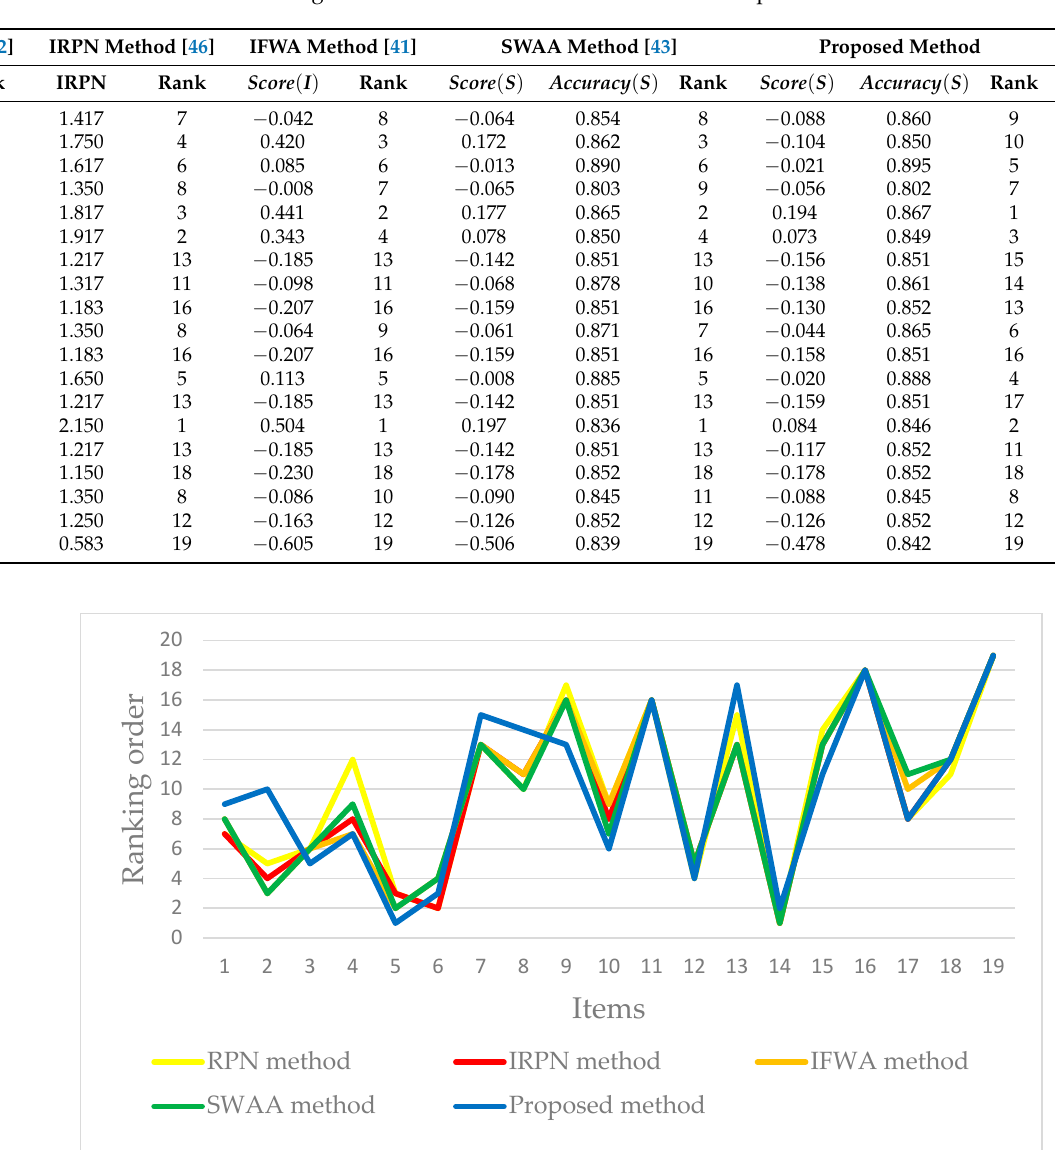
Table 8. The risk-ranking results of different calculation methods for potential failure mode.